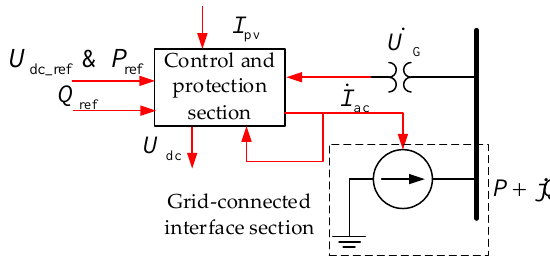
Figure 3. Connection relation of electromechanical transient model of inverter.